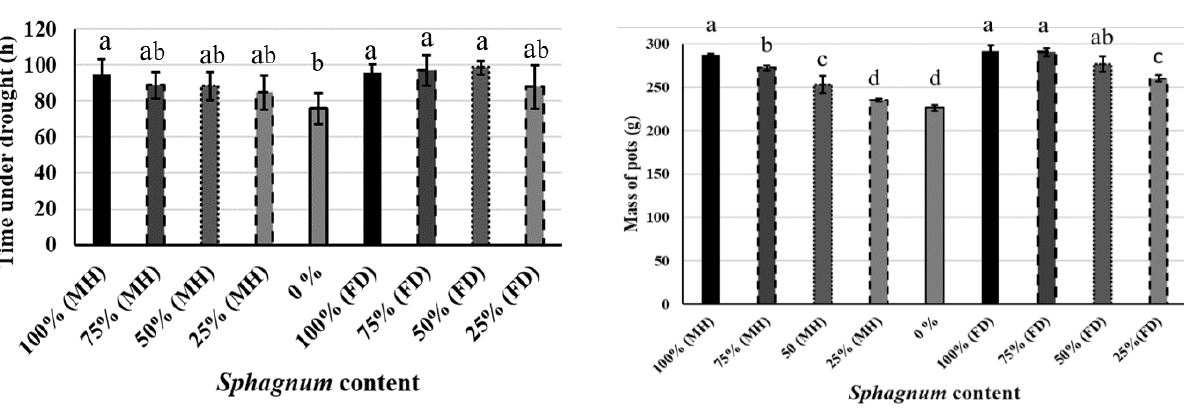
Figure 8. Pot mass at the beginning of the verbena experiment. FD = S. fuscum dominated biomass, MH = machine-harvested biomass. Target bulk density in all treatments was 67 kg m -3 . Differences between means (p < 0.05) are indicated by different letters (a, b, c, d). Error bars denote ± SD. n =